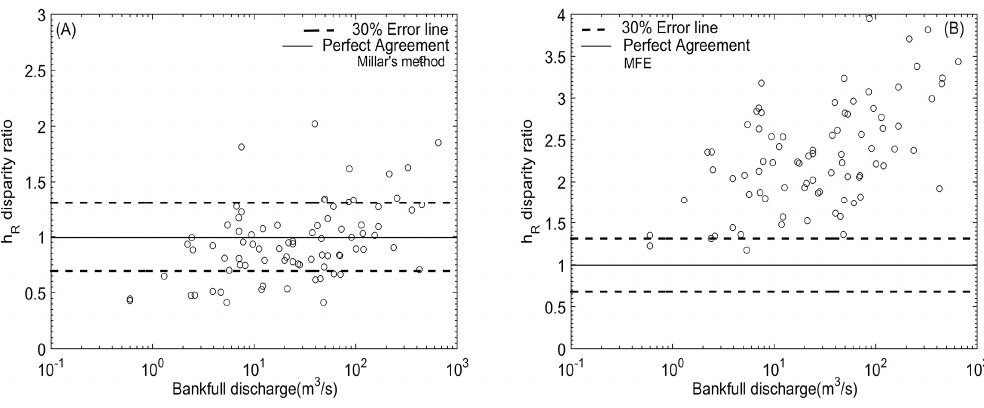
Figure 7. Scatter plot of disparity ratio B R against bankfull discharge for gravel bed channels [2,17,47,48]. ( A ) Millar’s Method; ( B ) MFE; ( C ) MFN; ( D ) ME and MEDR.